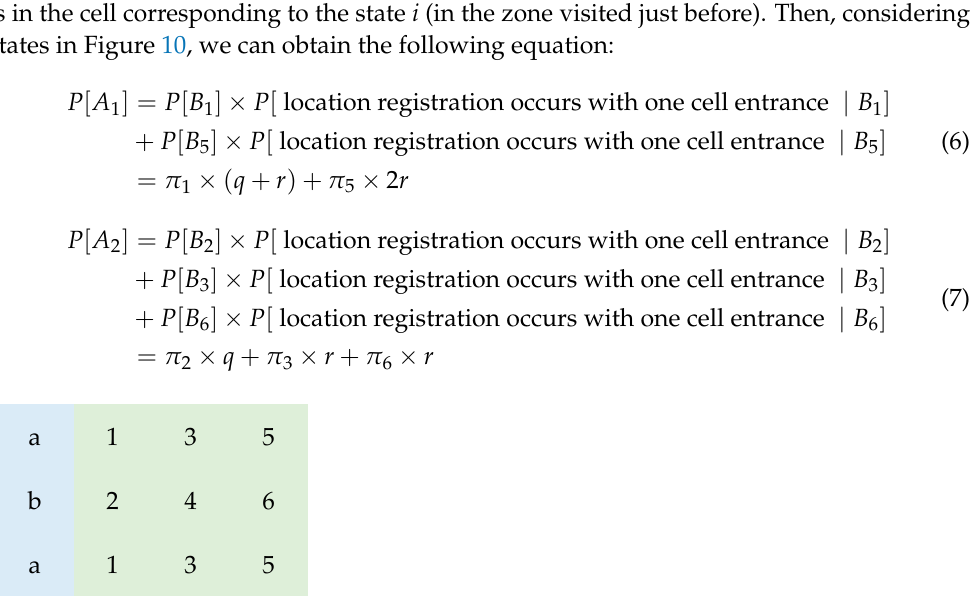
Figure 10. States in a zone when n =